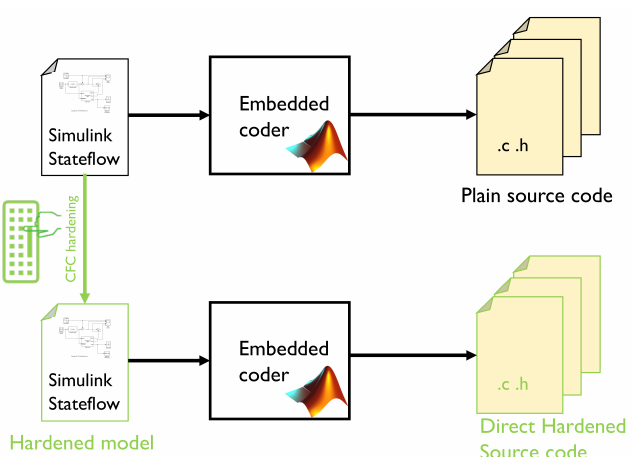
Figure 1. Model-based approach for implementing the CFC methods. The benchmarks are ob- tained by hardened them in the model, then generating the source code automatically thanks to the Embedded